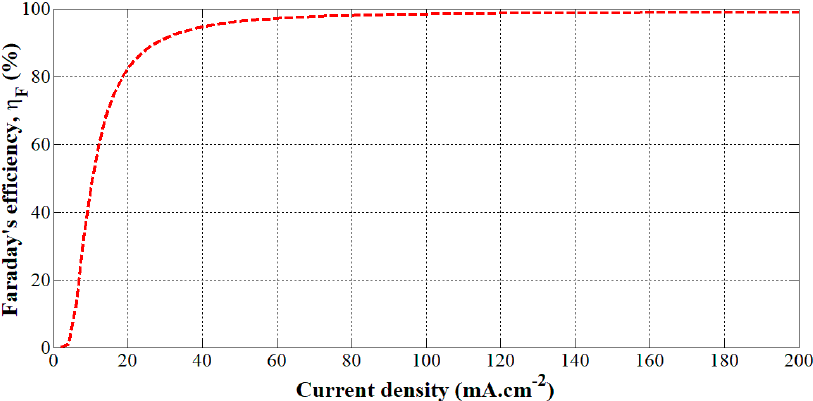
Figure 3. Faraday’s efficiency versus the current density for a given temperature (40 °C).